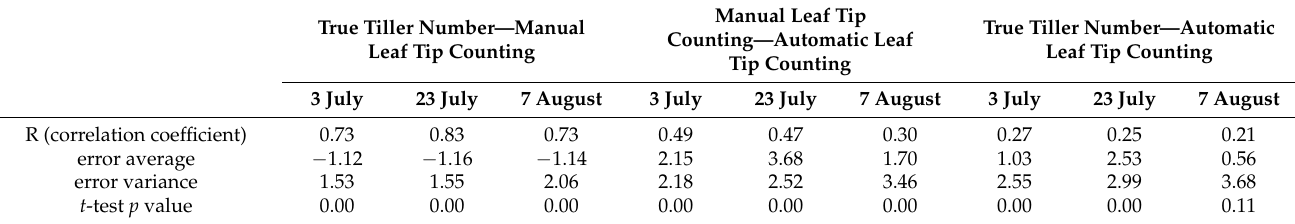
leaf-tip number (C). Table 2. Detailed table of observation Table 2. Detailed table of observation results.